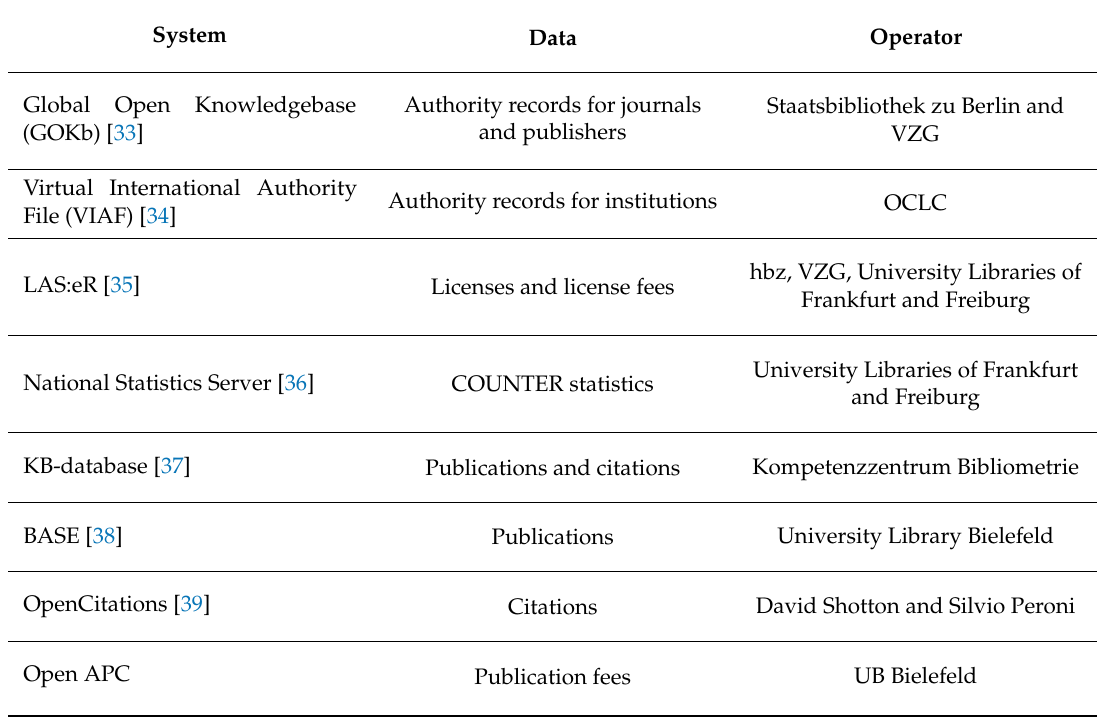
Table 4. Sources for the National Open Access